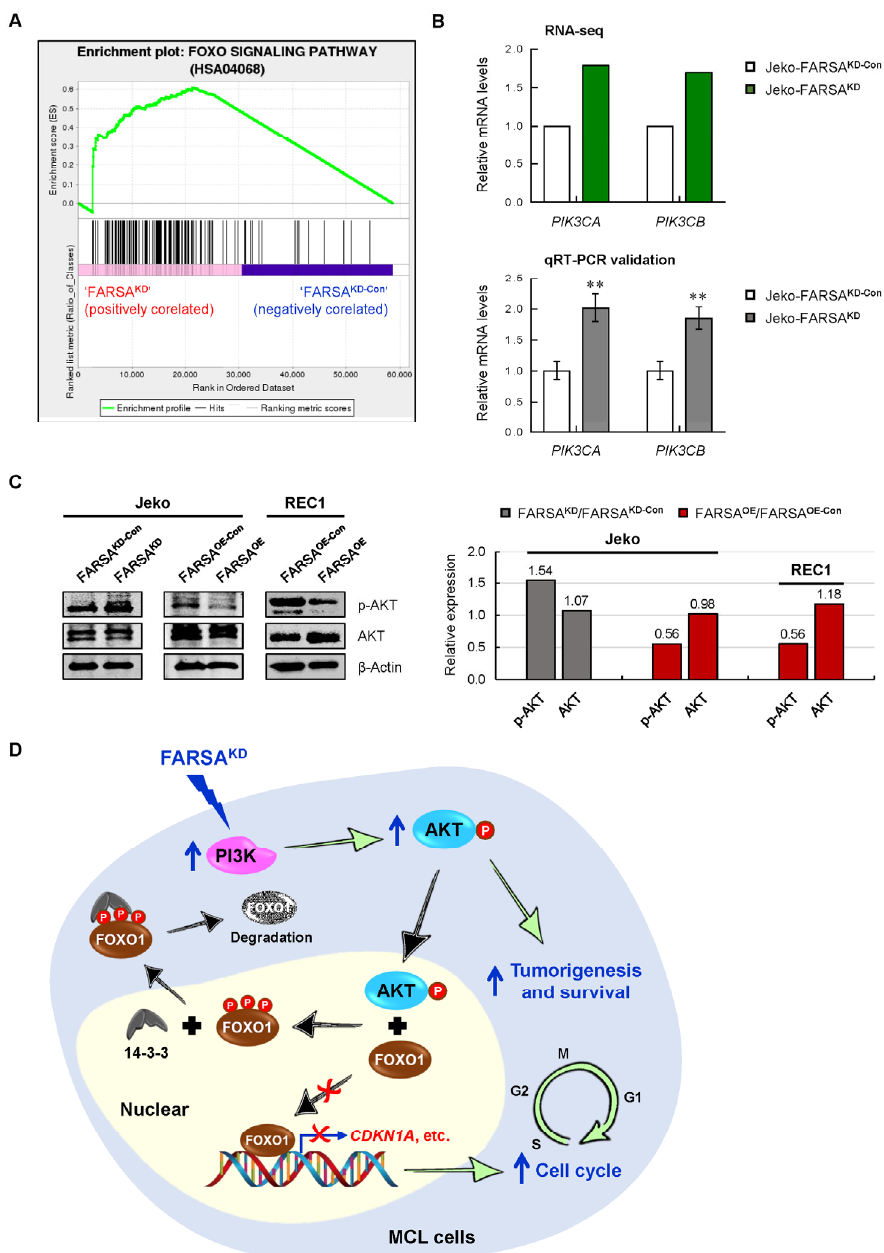
Figure 6. FARSA-mediated enhancement of PI3K-AKT signaling in MCL cells. ( A ) Enriched forkhead box O (FOXO) signaling pathway determined by Gene Set Enrichment Analysis (GSEA). ( B ) Relative mRNA levels of phosphatidylinositol-4,5-bisphosphaste 3-kinase catalytic (PIK3C) subunit alpha ( PIK3CA ) and PIK3C subunit beta ( PIK3CB ) from the RNA-seq ( upper ) and qRT-PCR ( lower ). Each value from the RNA-seq in FARSA KD Jeko cells was relative to the control cells. Each value from qRT-PCR was normalized to ACTB and is presented as the mean ± SD. ** p < 0.01 (vs. control group). ( C ) Immunoblots of phosphorylated AKT (p-AKT) and AKT in FARSA KD Jeko, FARSA OE Jeko and FARSA OE REC1 cells ( left ). β -Actin was used as a loading control. The expression of each protein was normalized to the corresponding β -Actin, and the relative expression of each protein in FARSA KD or FARSA OE cells is indicated relative to the control cells ( right ). ( D ) FARSA knockdown enhances the activation of PI3K-AKT signaling. AKT-mediated FOXO1 phosphorylation enables its binding to 14-3-3 proteins and nuclear export, leading to FOXO1 degradation. Both the enhanced activation of AKT and cell cycle acceleration caused by AKT-mediated FOXO1 inactivation ultimately contribute to the oncogenic phenotypes of the FARSA KD MCL